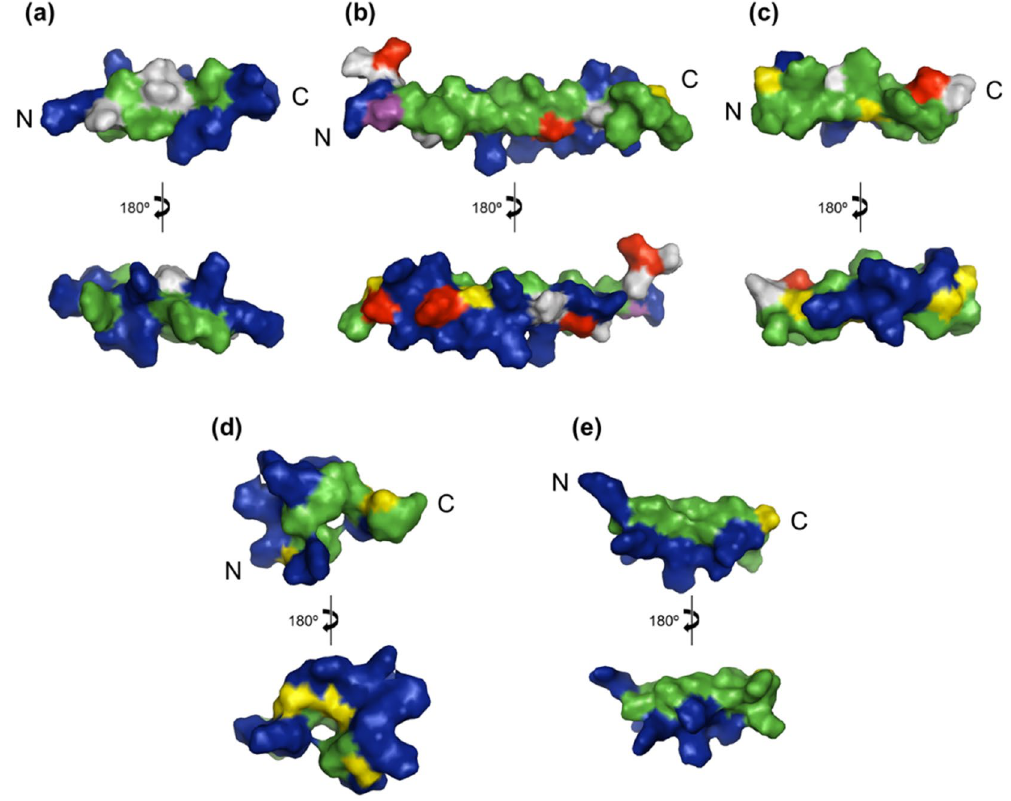
Figure 8. Surface structural characteristics of penetratin ( a ), LL-37 ( b ), magainin 2 ( c ), SMAP-18 ( d ), and G2,7,13A ( e ). The amino acids residues are colored as follow: positively charged residues in blue; negatively charged residues in red; hydrophobic residue in green; glycine in